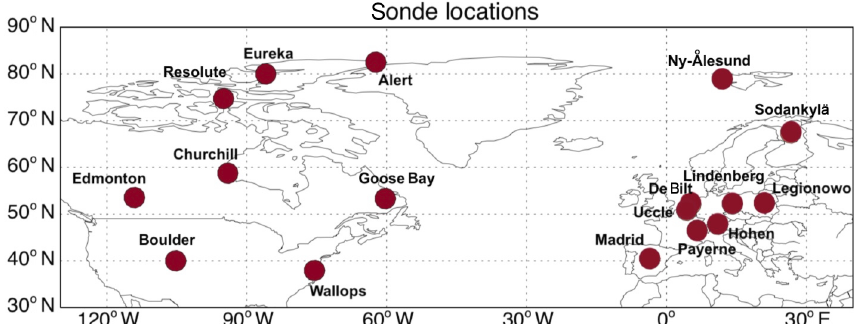
Figure 1. Map of ozonesonde sites selected in this study.